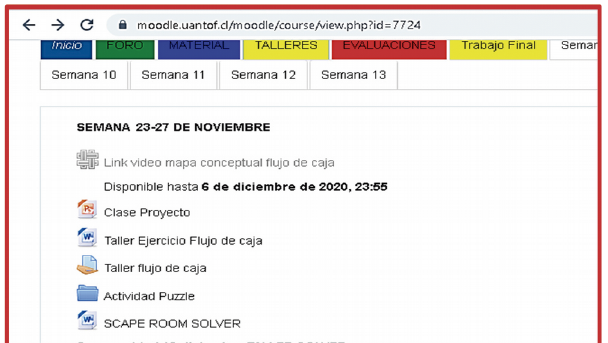
Figure 16. Cash Flow Exercise